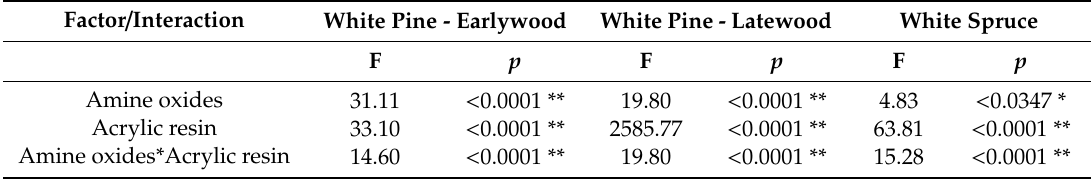
Table 9. F ratio and p value of the statistical analyzes for the impregnation depth test. Factor / Interaction White Pine -